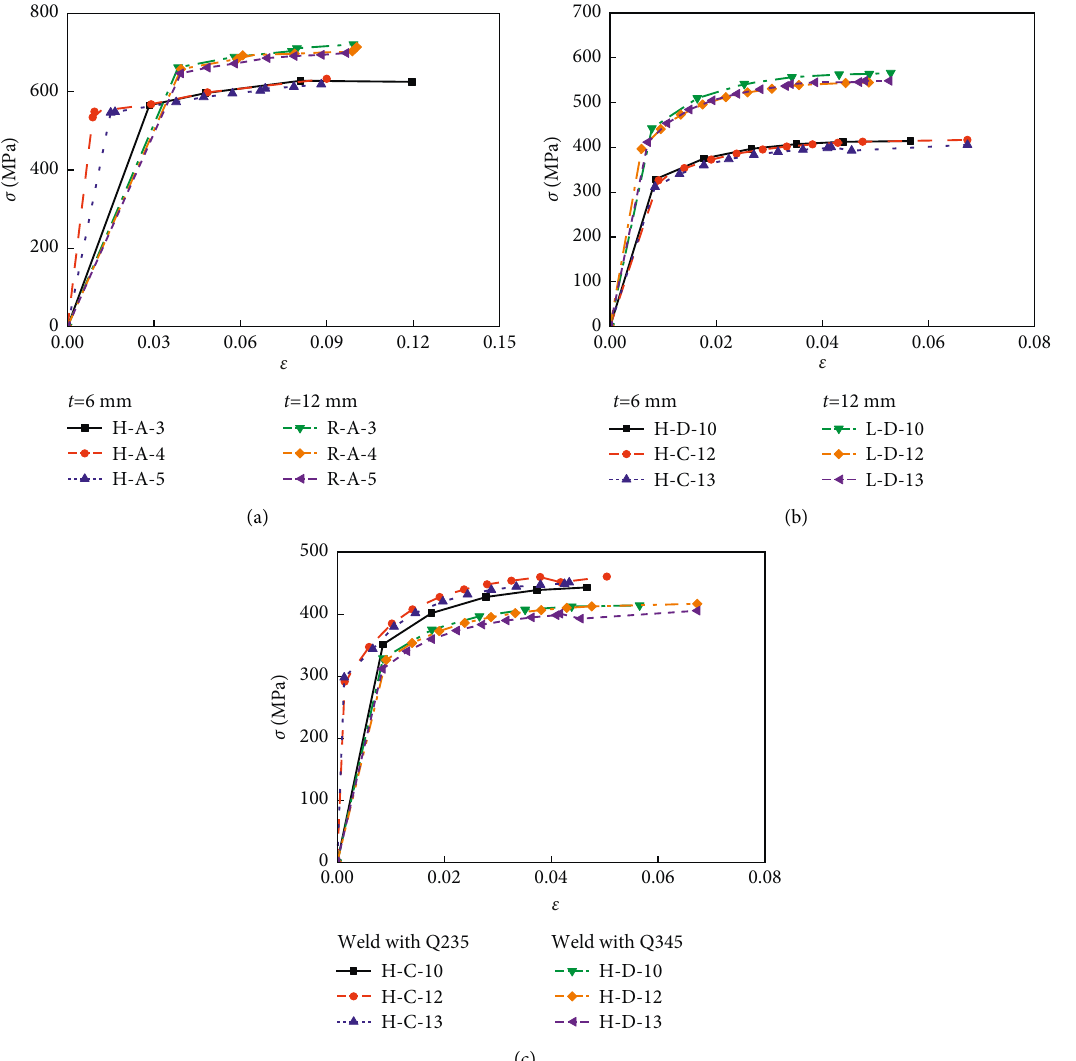
Figure 11: Skeleton curves of specimens. (a) Skeleton curves of specimens without welded joint. (b) Skeleton curves of material specimens with different thickness. (c) Skeleton curves of material specimens with different material strength of the